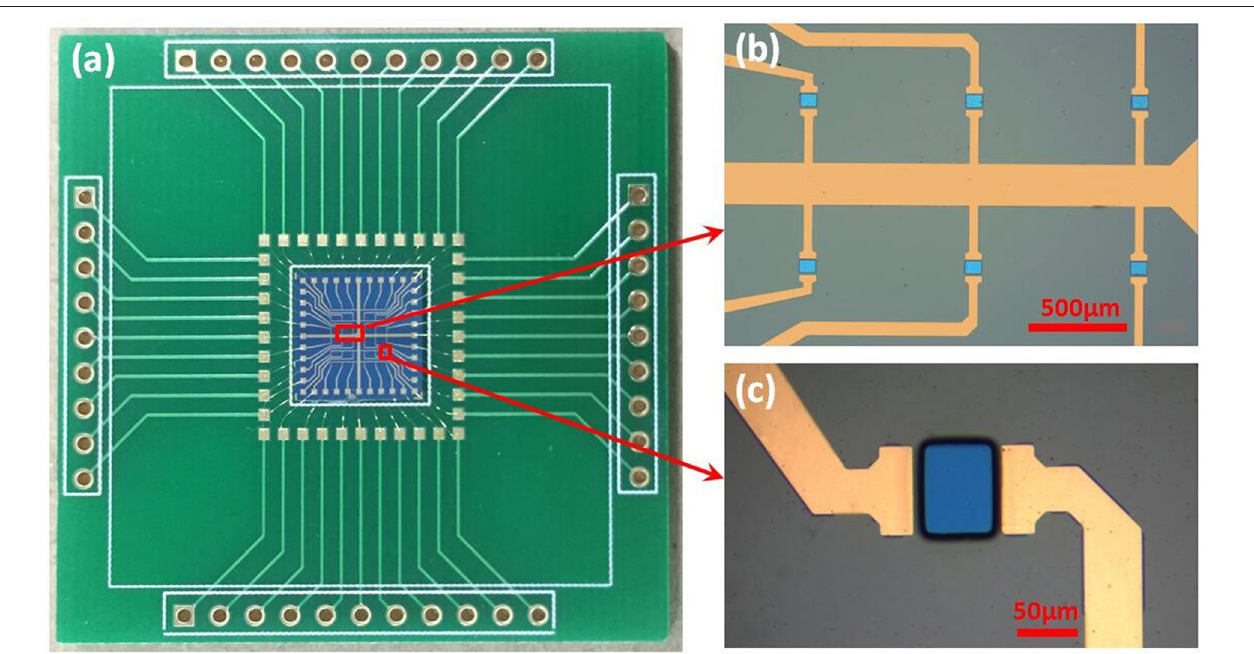
FIGURE 3 | The photograph of the fabricated sensor: (a) the packaged sensor with PCB; (b,c) the microstructure of GFET array obtained by optical microscopy.